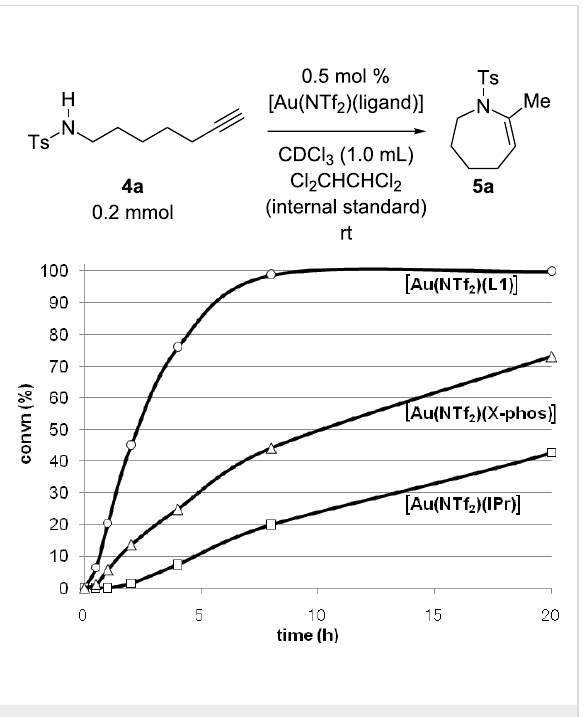
Figure 3: Time–conversion profiles for the gold-catalyzed cyclization of 4a with L1 , X-Phos and IPr